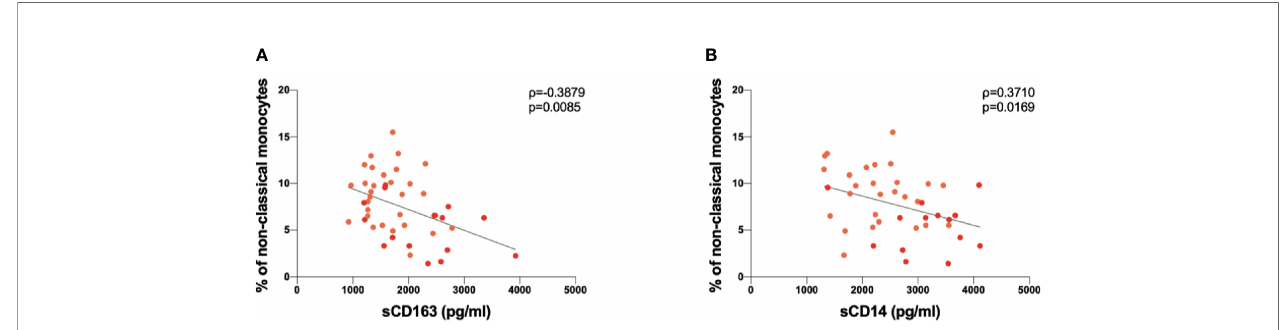
FIGURE 4 | Correlations between sCD163 and sCD14 plasmatic levels and immunophenotyping analysis data performed in COVID-19 subjects. (A) Negative correlation between sCD163 plasmatic levels and percentages of non-classical monocytes. Linear correlation was evaluated by using the regression test, R 2 = 0.179 p=0.004. Patients with acute respiratory distress syndrome (ARDS) are represented in red, while patients without ARDS in orange. (B) Positive correlation between sCD14 plasmatic levels and percentages of non-classical monocytes. Linear correlation was evaluated by using the regression test, R 2 = 0.134 p=0.019. Patients with ARDS are represented in red, while patients without ARDS in orange. All correlations were performed using Spearman test. Spearman coef fi cient ( r ) and statistical signi fi cance (p) are reported in the